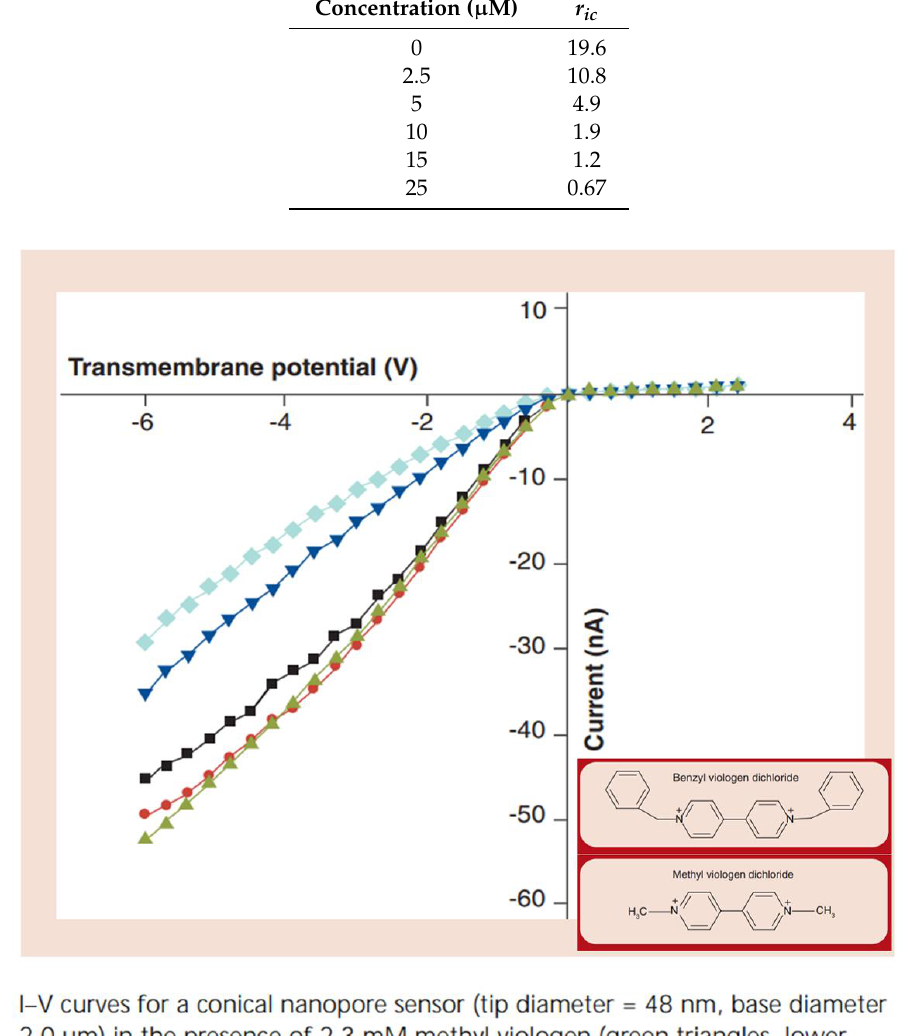
Figure 5. Rectified I–V curve in the presence of various concentrations of methyl viologen and benzyl viologen. Reprinted and adapted with permission from [26]. Copyright 2008, Future Medicine.